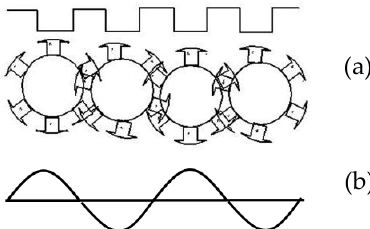
Figure 5. EMF wave production in single-phase generator when the rotor is moving from head to tail: ( a ) cross-section view of the stator and rotor; ( b ) corresponding sinusoidal wave form.